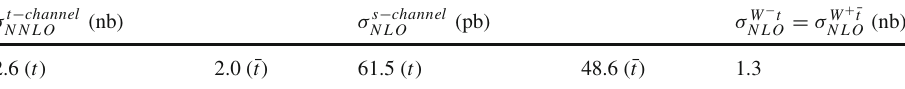
Table 6.2 Total single-top production cross sections at FCC-hh for m top = 172 . 5 GeV